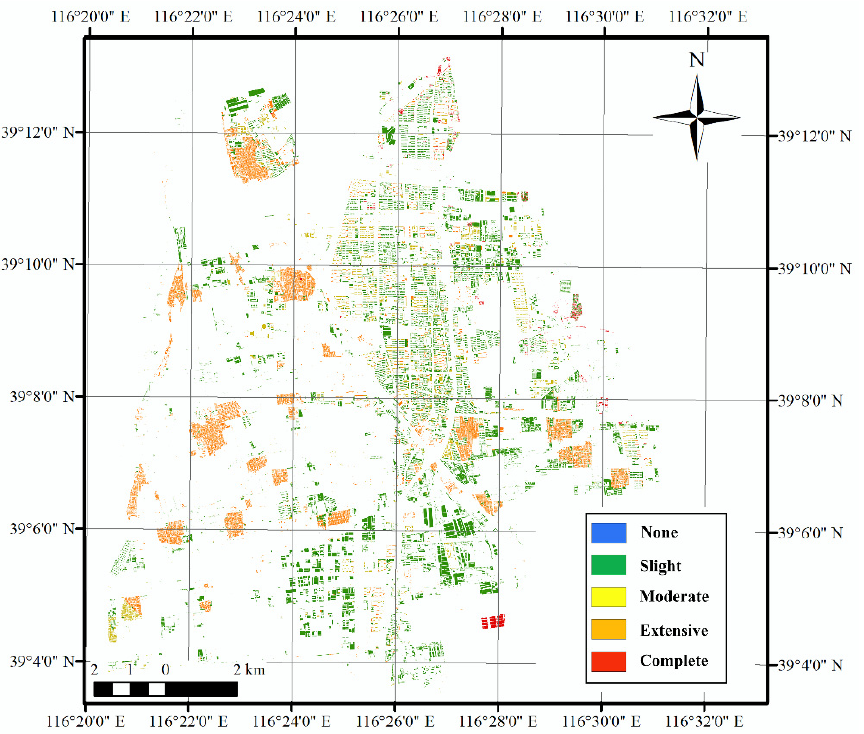
Figure 25. Distribution of seismic damage in Daxing downtown.